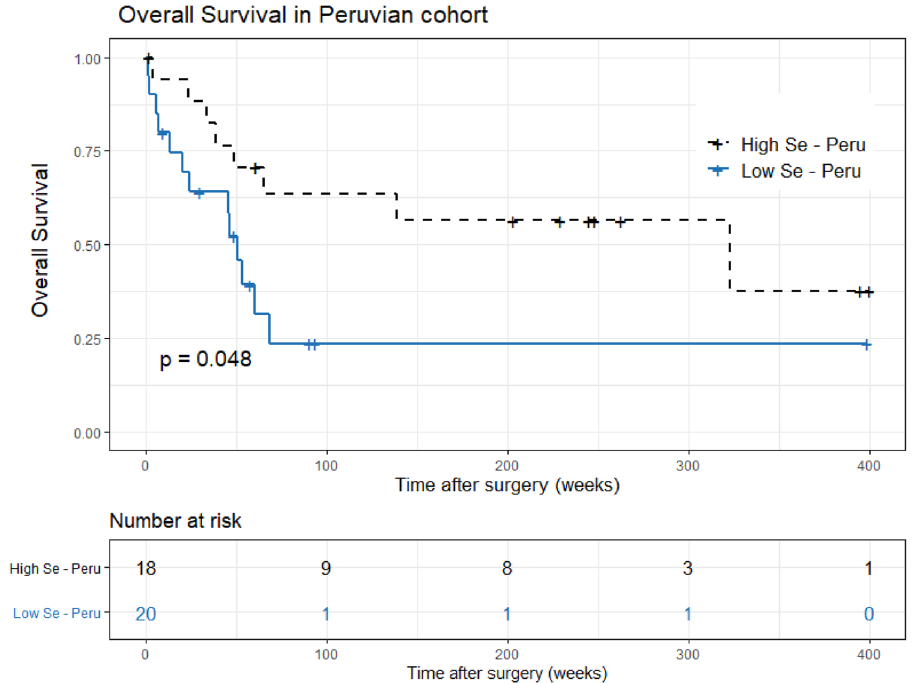
Figure 4. Survival plot in relation to selenium concentration in tumoral tissues in Peruvian cohort of patients. A significant decrease in survival duration is found for patients with low levels of Se in comparison to those with higher levels. Level significance ( p < 0.05) was calculated using the Kaplan–Meier